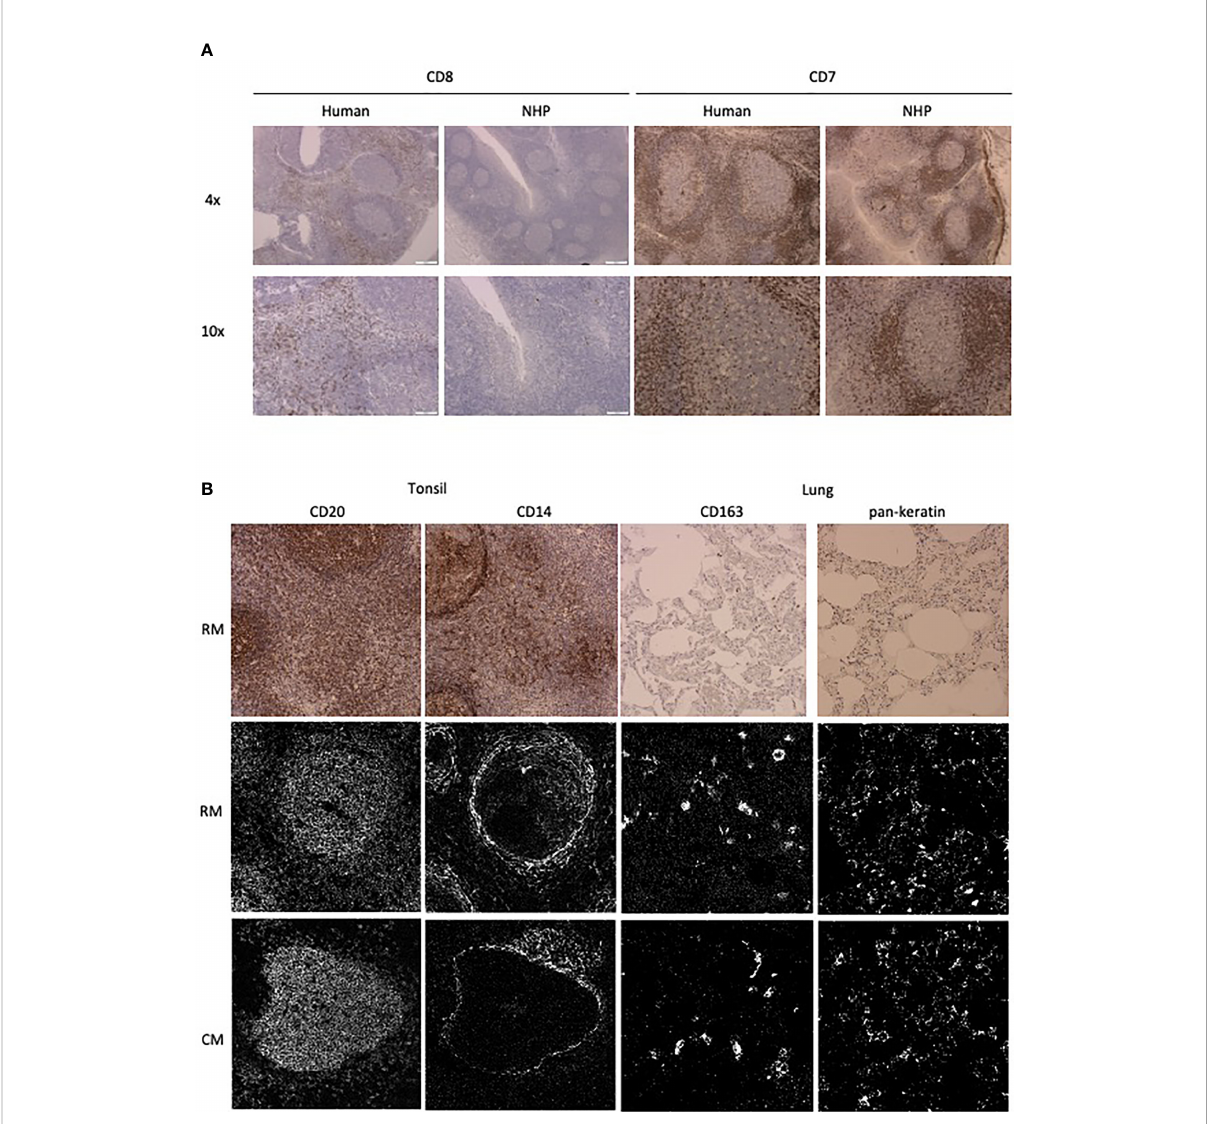
FIGURE 2 Antibody performance in human and NHP tissue. (A) IHC staining pattern of antibody clones in human (left) and NHP (right) tonsil tissue. CD7 and CD8 staining is representative of staining variation between human and NHP tissue. (B) Comparison of antibody staining pattern on NHP tissue between IHC and IMC. Tissue relevant markers were chosen, with CD20 and CD14 staining shown in the tonsil and CD163 and pankeratin staining in the lung tissue. IHC staining is shown in rhesus macaque tissue (top row) and IMC staining is shown for both rhesus (middle row) and cynomolgus macaque (bottom row)